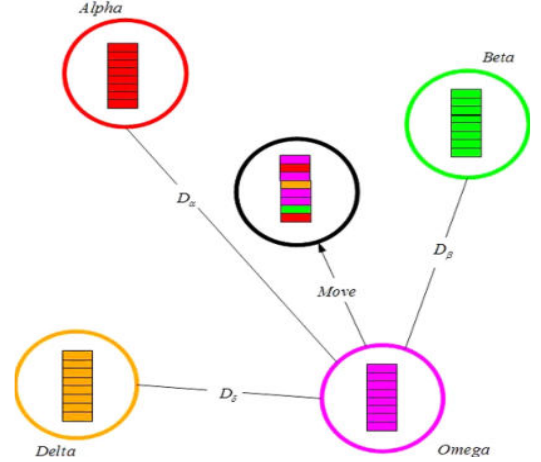
Figure 1. Position updating by